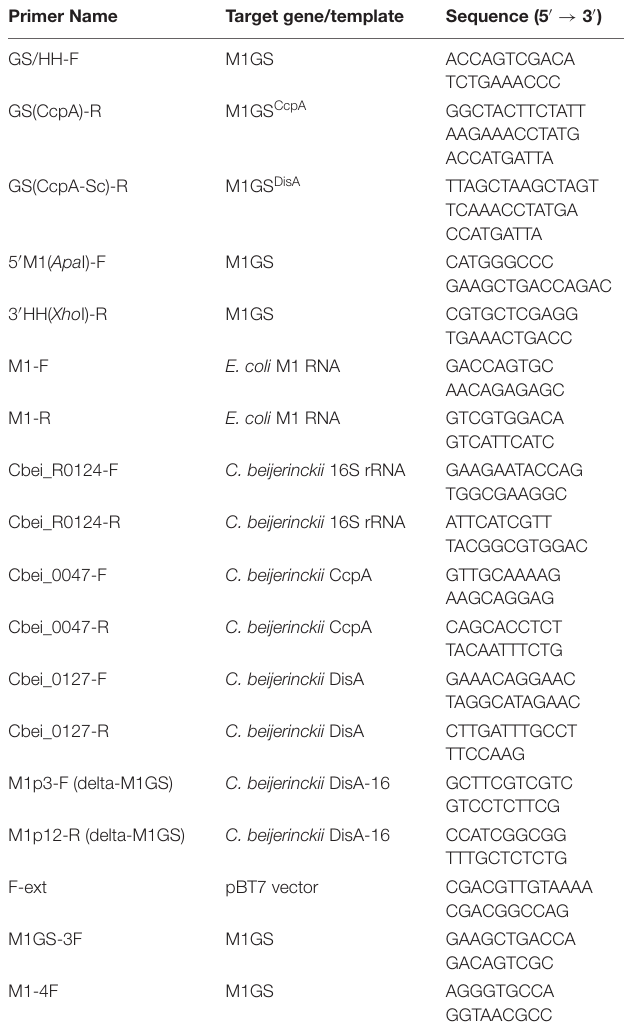
TABLE 1 | Sequences of oligonucleotides used in this study. Primer Name